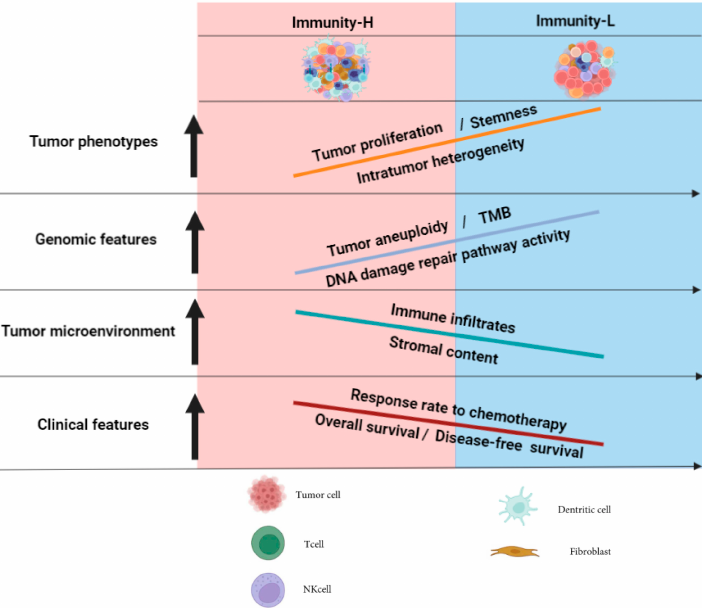
Figure 7. A summary of molecular and clinical characteristics of the immune subtypes of ACC. The figure was created with BioRender.com.